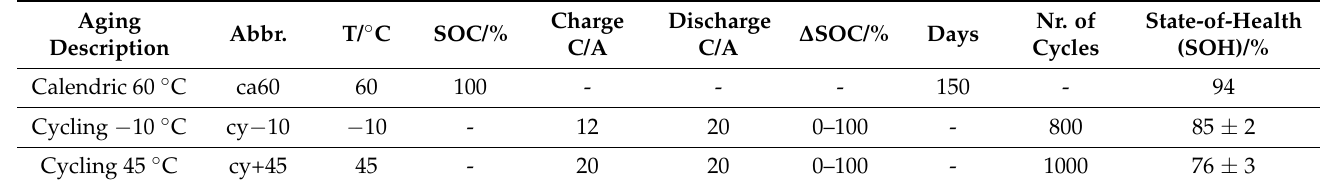
Table 2. Key parameters of the aging experiments using cell type